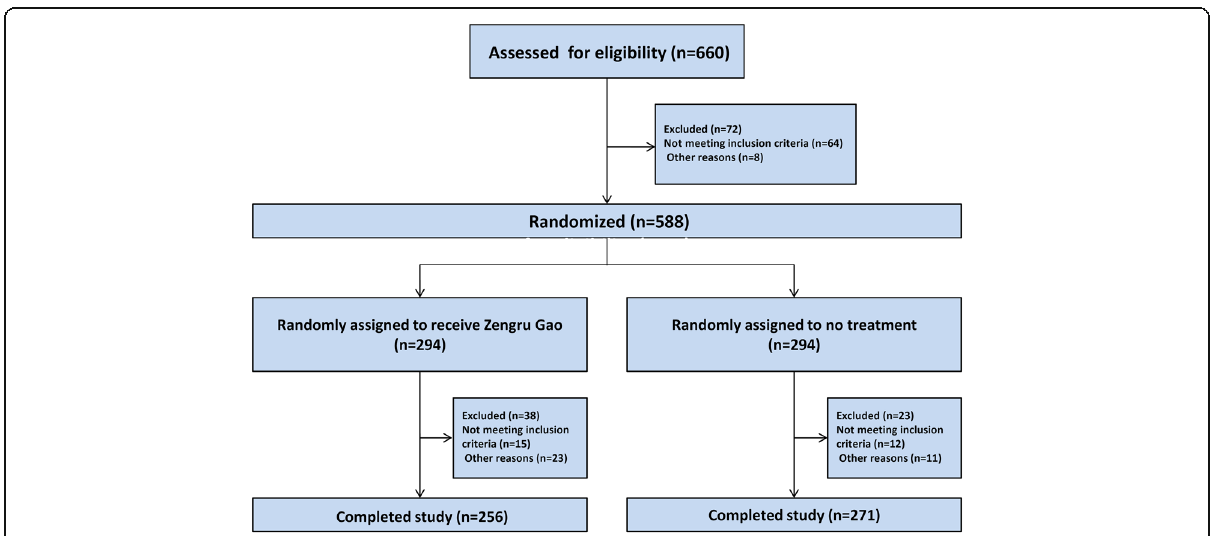
Fig. 1 Flow chart of design and recruitment of participants according to CONSORT